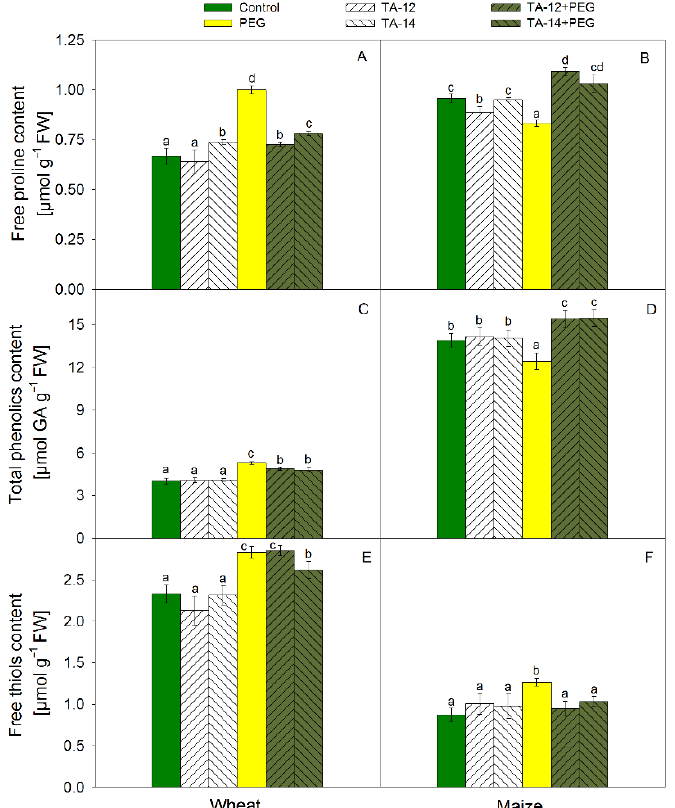
Figure 3. Free proline ( A , B ), total phenolics ( C , D ), and free low-molecular weight thiols ( E , F ) con- tents in shoots of wheat ( A , C , E ) and maize ( B , D , F ) foliar sprayed with 1 mM TA-12 or TA-14 and subjected to 10% PEG for 72 h. Data are mean values ± SE. Different letters designate a statistically significant difference at p < 0.05.